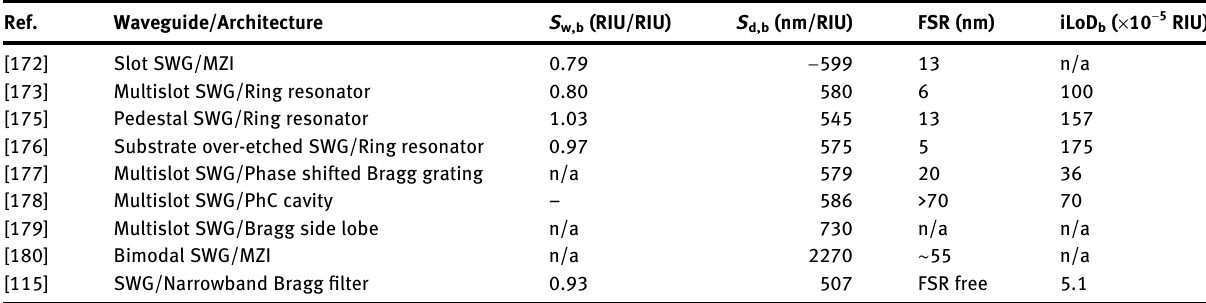
Table  : Main performance metrics of SWG-based sensors.